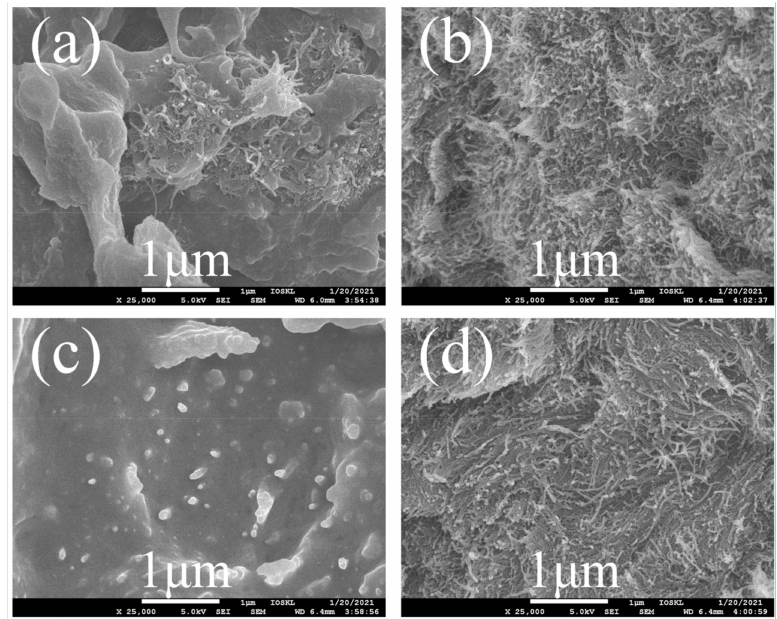
Figure 7. SEM images of ( a ) 10 wt% MWCNTs-COOH/PEEK; ( b ) 20 wt% MWCNTs-COOH/PEEK; ( c ) 8.7 wt% PEK-C-OH-g-MWCNTs-COOH/PEEK; ( d ) 17.4 wt%